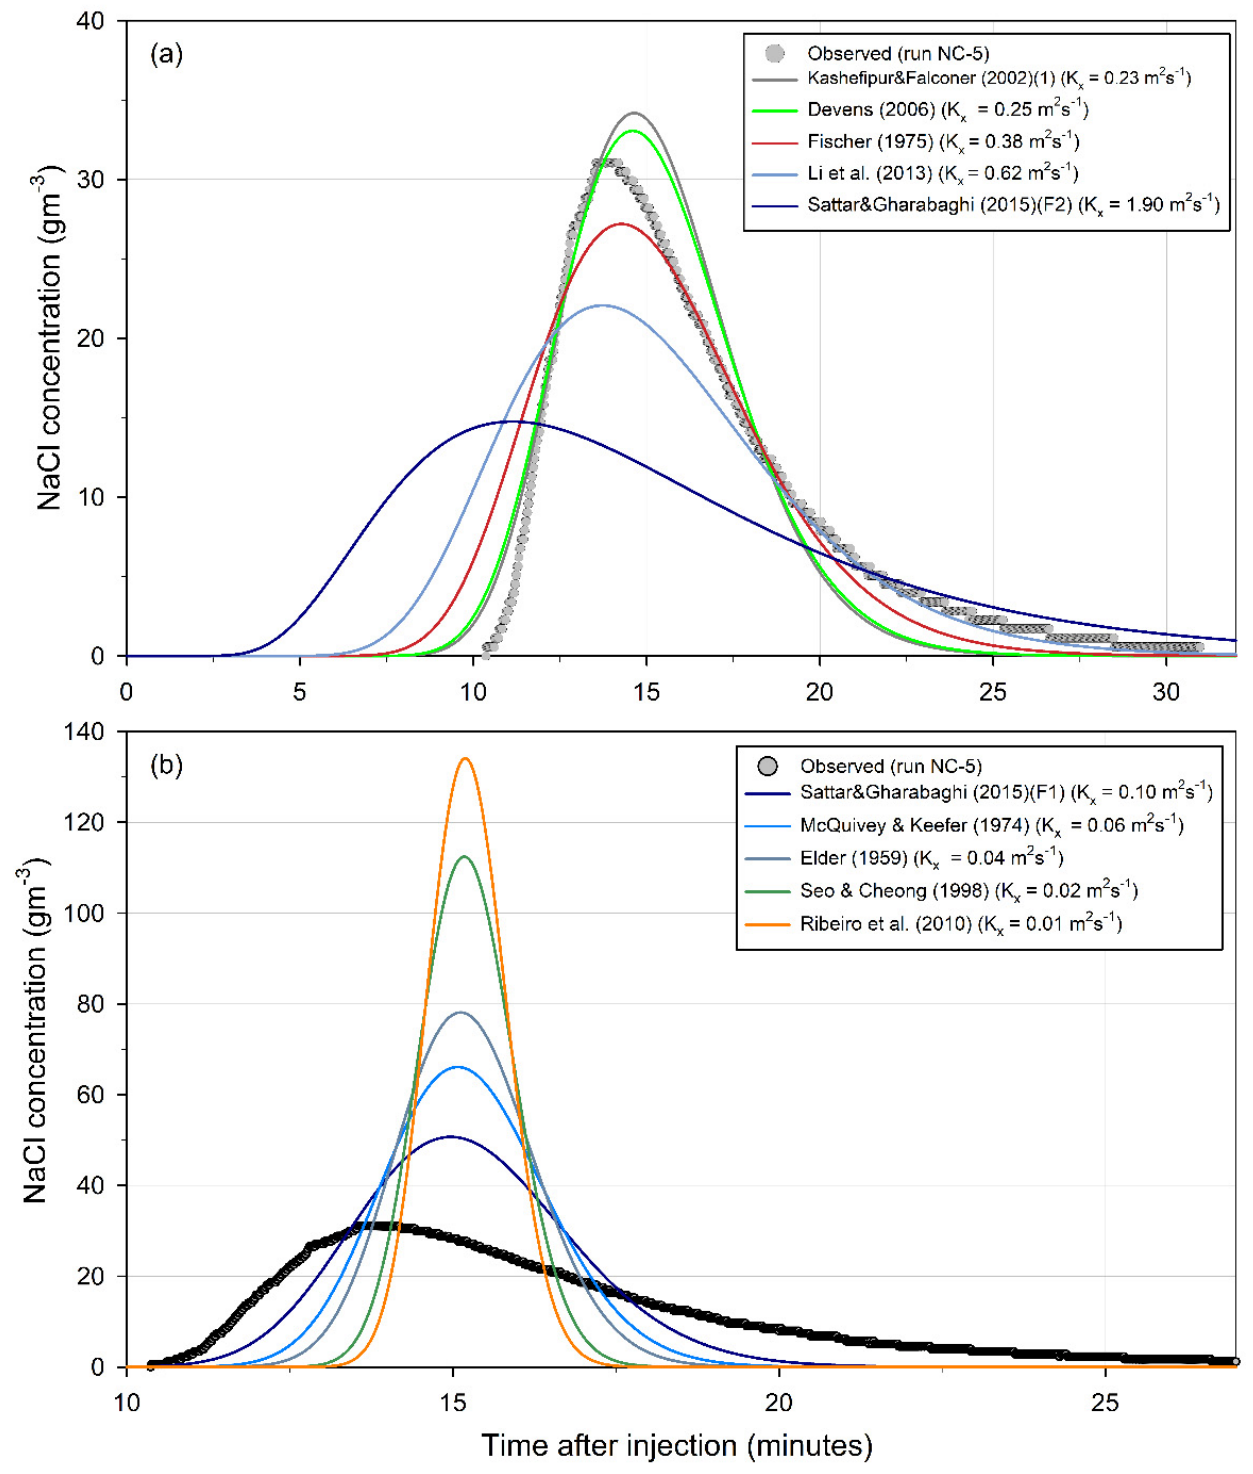
Figure 11. Modeled concentration curves utilizing the longitudinal dispersion coefficients obtained from a sample of predictive formulae in the natural channel, 127.9 m downstream of the injection location. Curve with round symbols shows the observed plume, which is a common reference for both graphs (note the scale change on both axes). ( a ) Formulae that underestimated the peak concentration. ( b ) Formulae that overestimated the peak concentration.